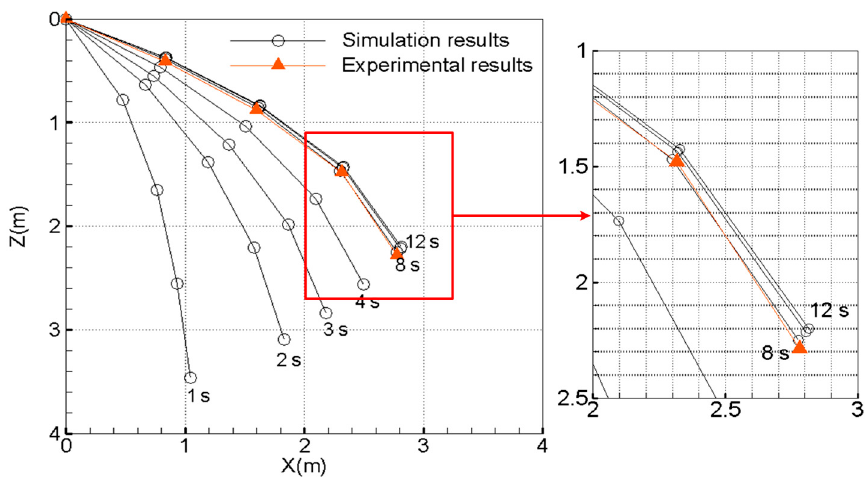
Figure 6. Comparison of the simulation results with the experimental results.